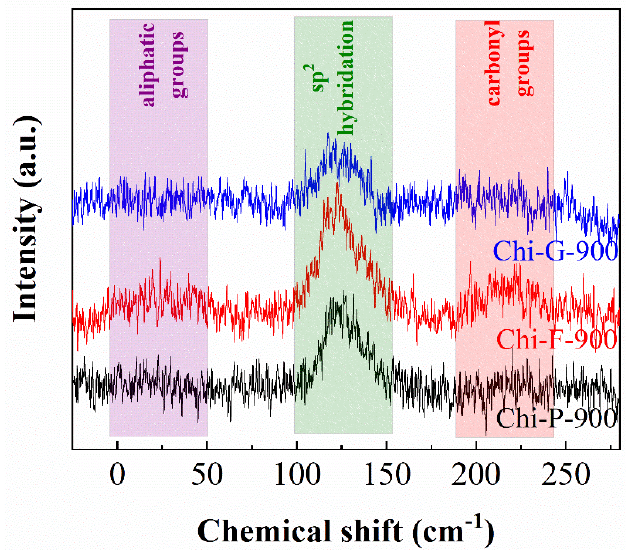
Figure 5. 13 C NMR of biochars obtained from chitosans with different morphologies pyrolyzed at 900 °C.